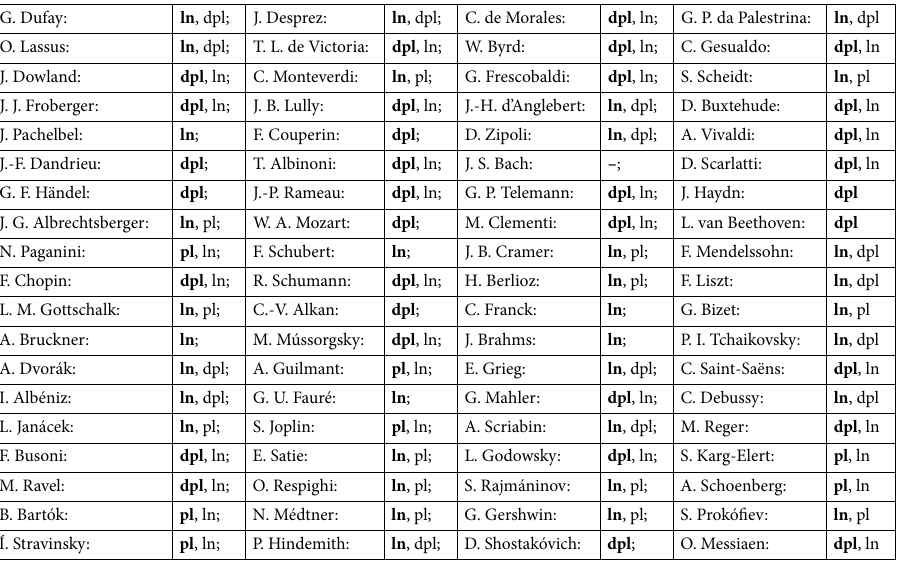
Table 1. Name of the 76 classical composers in the Kunstderfuge corpus analyzed in this paper. The order is chronological (from left to right and from top to bottom, established by the average between birth and death). The results of the best fit (in bold), followed by other good fits are included. pl = (simple) power law, dpl = double power law, ln = lognormal. Number of composers fitted by a unique distribution: 14 ( pl 0; dpl 8; ln 6). Number of composers with two good fits: 61 ( pl , ln 7; dpl , ln 25; ln , pl 14; ln , dpl